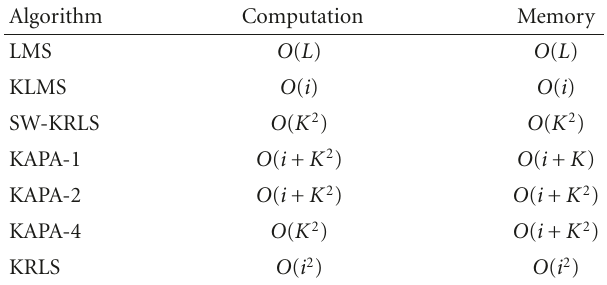
Table 5: Complexity comparison at iteration i .